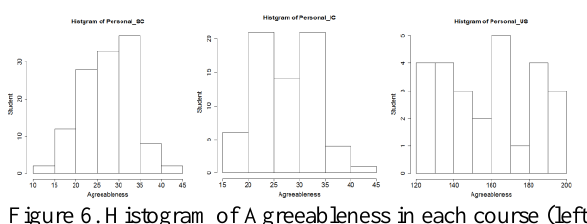
Figure 6. Histogram of Agreeableness in each course (left: SDC, center: ITC, right: ODC)